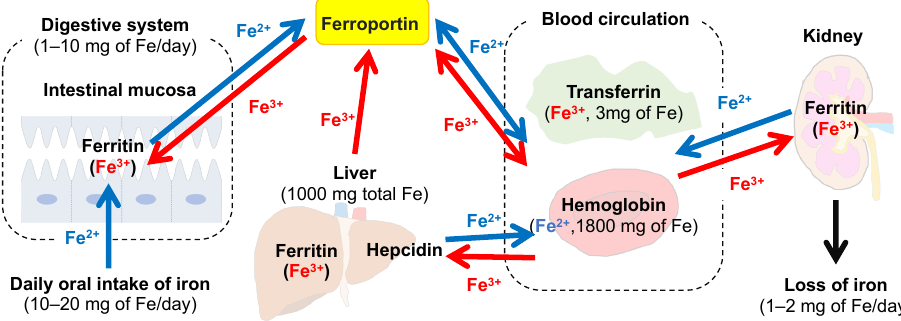
Figure 1. Distribution of iron in the body and the main organs involved in the regulation of iron metabolism (modified from permission from [39] under the Creative Commons CC BY 4.0 license, https://creativecommons.org/licenses/by/4.0/ (accessed on 28 July 2022)). Values data for iron levels are obtained from Lesjac et al.